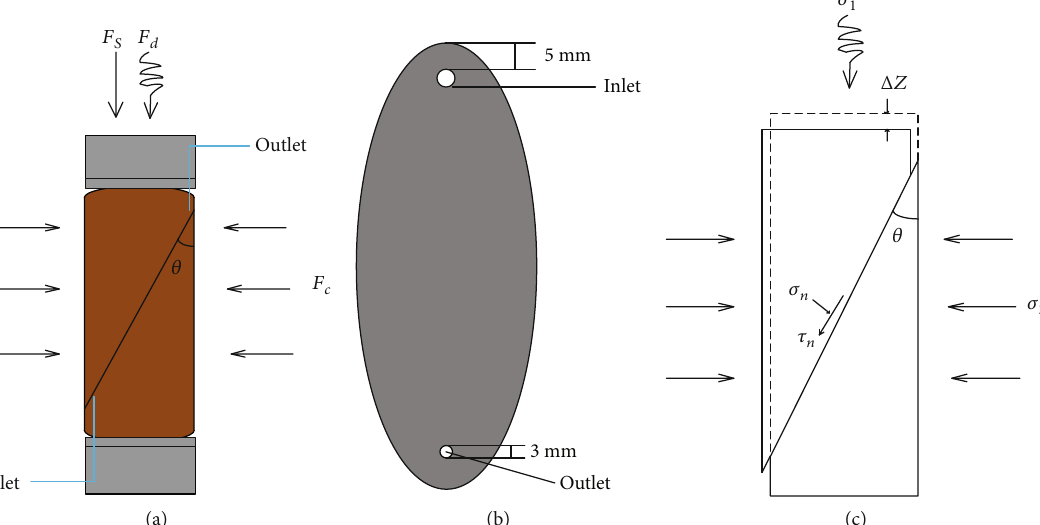
Figure 1: (a) Sketch of fractured rock sample; (b) a saw-cut fracture with boreholes for fl uid fl ow; (c) sketch of fracture deformation during